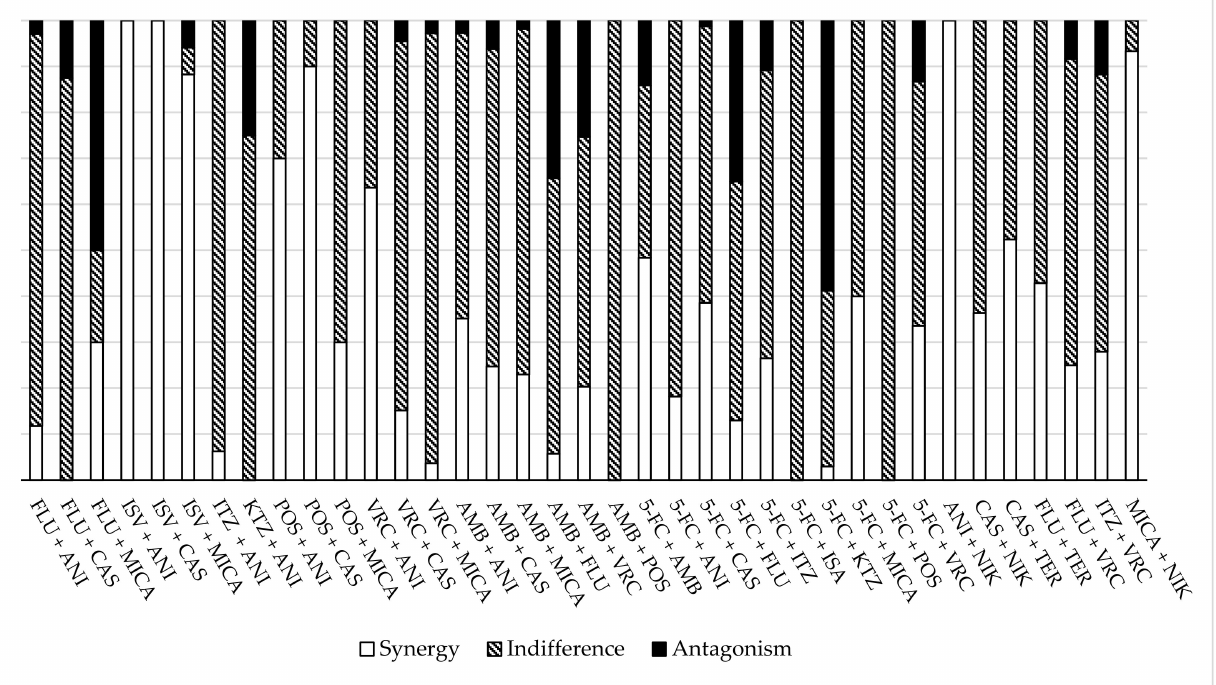
Figure 2. Percentage of synergy, indifference and antagonism of the antifungal combinations in in vitro